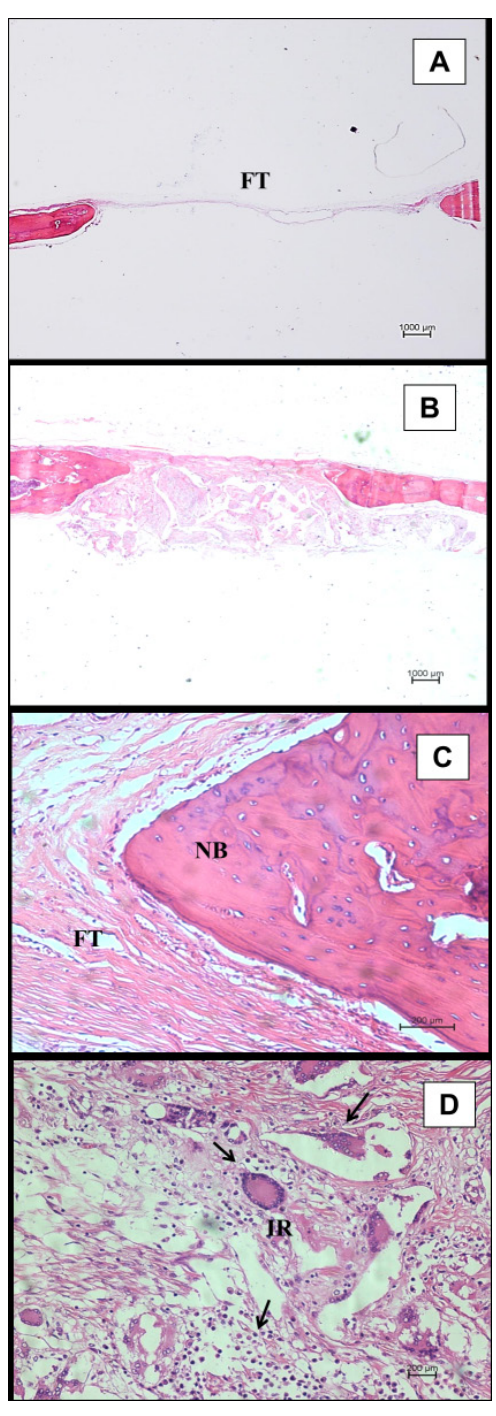
Figure 5. Histological alterations eight weeks after scaffold implantation. Light microscopy (HE) of the critical size calvarial defect at the control (empty defect) and scaffold-treated (PLDLA construct) sites. (A) The control site showed the presence of thin fibrous tissue (FT). (B) Panoramic image of the implanted PLDLA construct. (C) Fibrous tissue (FT) formed at the interface between new bone (NB) and the PLDLA scaffold implantat the defect margin. (D) Severe inflammatory reaction (IR) showing lymphocytes, macrophages and foreign-body giant cells (arrows) inside the implanted PLDLA